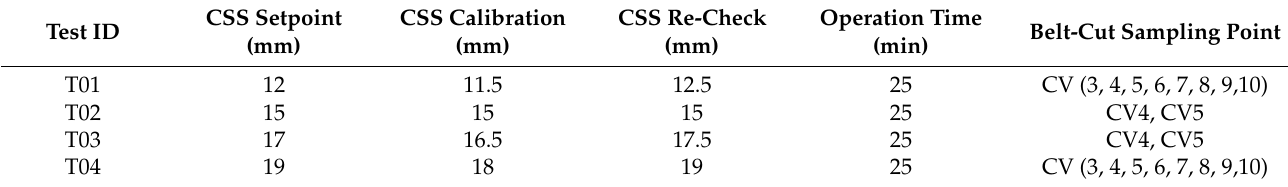
Table 1. Experimental noted values for the crushing